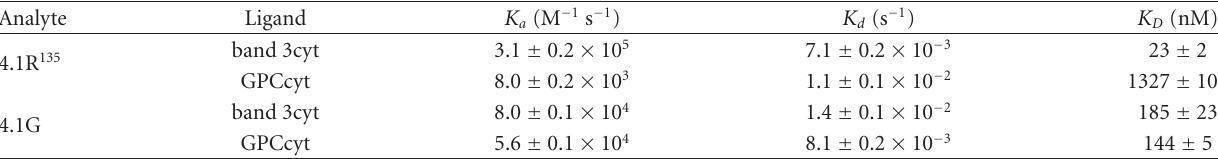
Table 1: 4.1R 135 and 4.1G binding to membrane proteins.